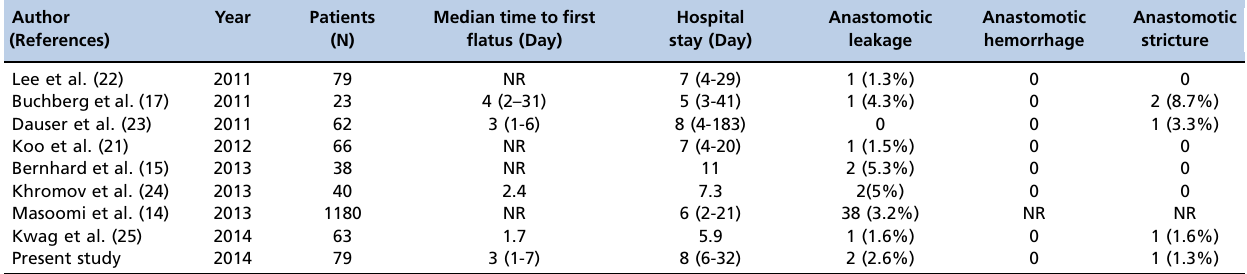
Figure 6 - The 3-year overall survival (OS) was 83.1% (CAR group) and 89.0% (STA group), p =0.152(A). In the stage 0-III patients, the 3-year OS was 94.5% (CAR group) and 98.2% (STA group), p =0.205; (B) in the stage IV patients, the 3-year OS was 12.1% (CAR group) and 32.3% (STA group), p =0.170 (C). Table 5 - Summary of the anastomosis-related postoperative complications that occurred in the patients using the nitinol compression